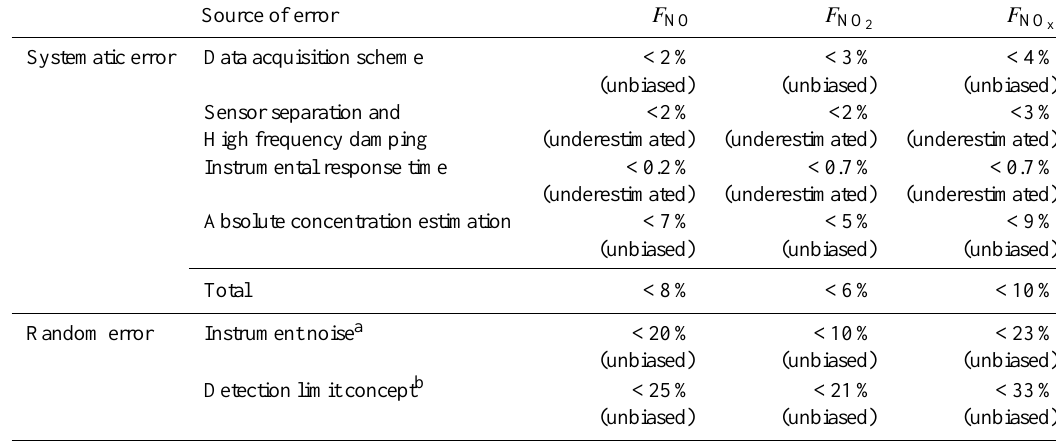
Table 1. Estimated flux analysis errors.